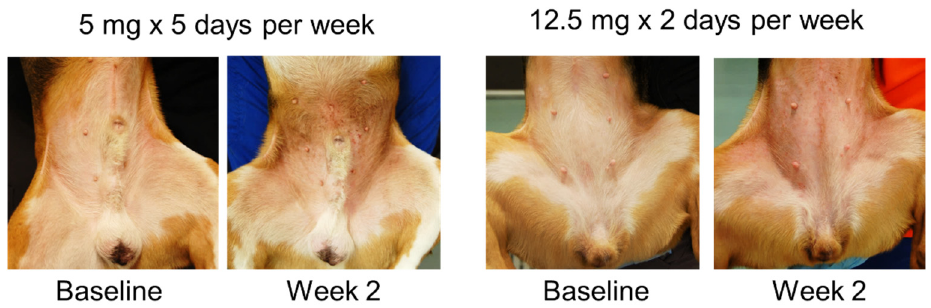
Figure 6. Examples of dogs’ presentations in the two groups at baseline and after two weeks of challenges.